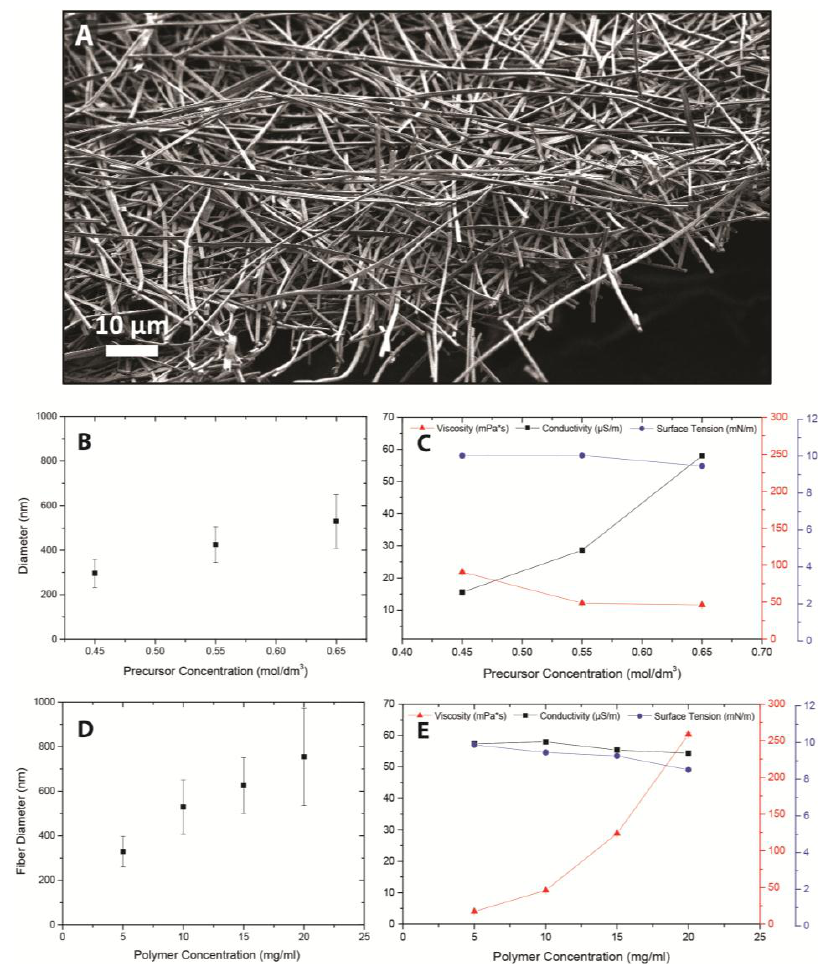
Figure 2. ( A ) Scanning electron microscopy (SEM) picture of three percent yttria partially-stabilized zirconia (3YSZ) fibers. Precursor concentration 0.65 M, polymer concentration 10 mg/mL polyvinylpyrrolidone (PVP). Influence of precursor concentration on ( B ) fiber diameter (nm) and ( C ) solution conductivity (μS/m; black squares), static viscosity (mPa·s; red triangles) and surface tension (mN/m; blue circles). Polymer concentration 10 mg/mL. Influence of polymer concentration on ( D ) fiber diameter (nm) and ( E ) solution conductivity (μS/m; black squares), static viscosity (mPa·s; red triangles) and surface tension (mN/m; blue circles). Precursor concentration 0.65 M.